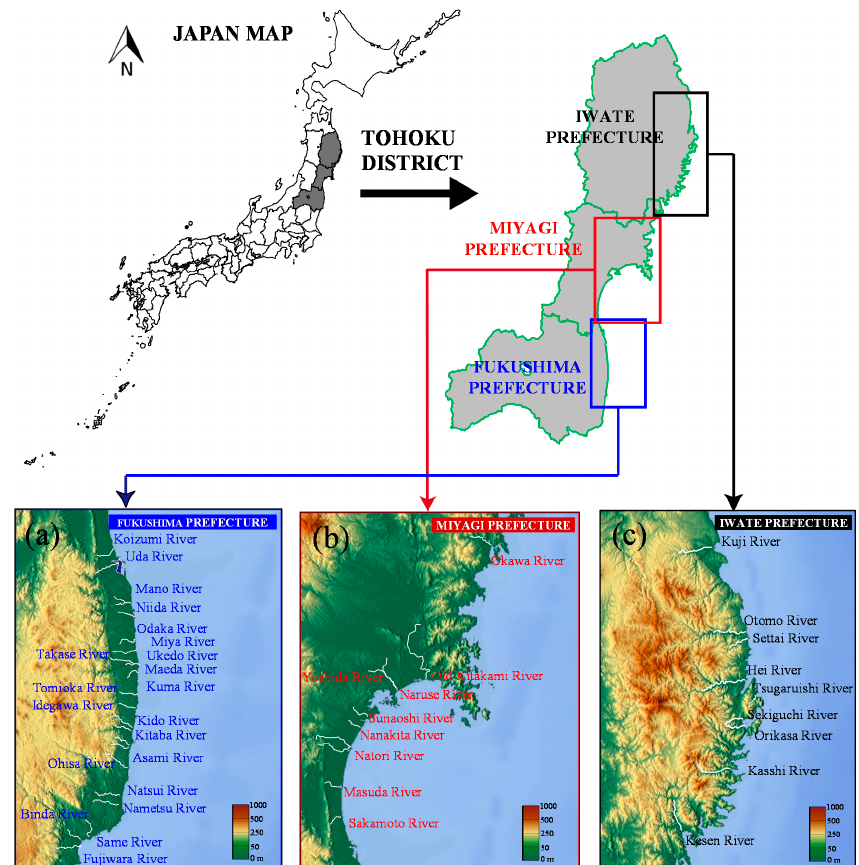
Figure 1. Location of study areas on the Japan map. ( a ) Rivers in Fukushima Prefecture. ( b ) Rivers in Miyagi Prefecture. ( c ) Rivers in Iwate Prefecture.